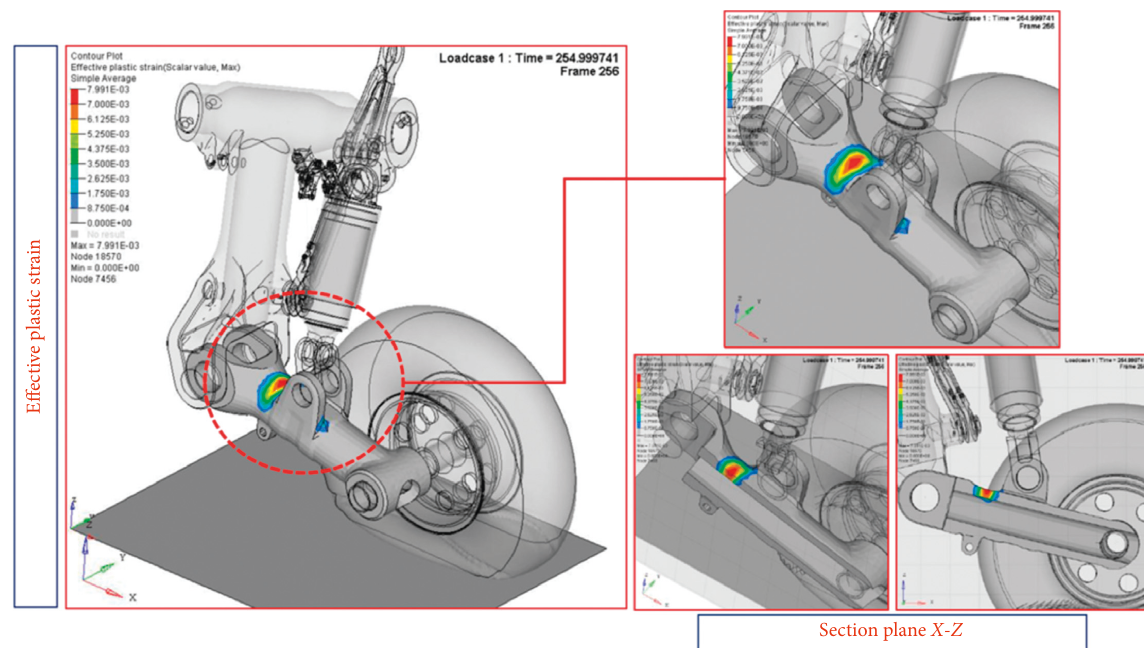
Figure 37: Effective plastic strain map for the trailing